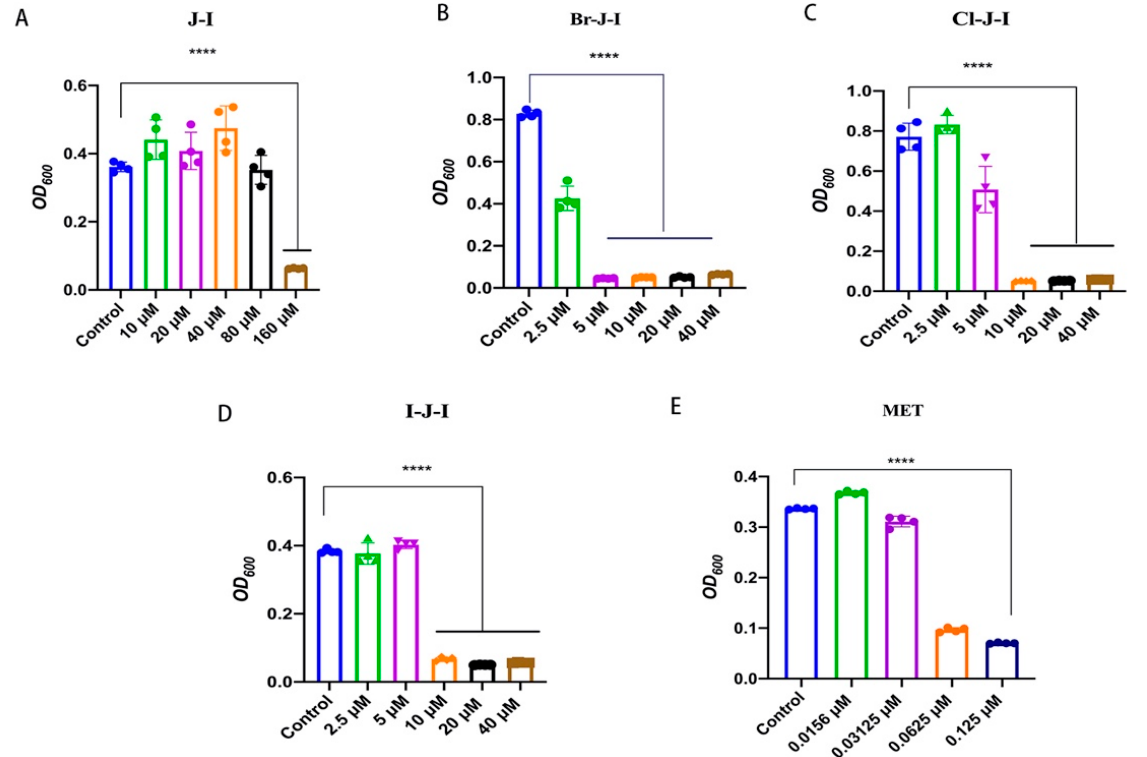
Figure 1. Antimicrobial activities of AMP Jelleine-I (J-I) and its derivatives against Fusobacterium nucleatum ( Fn ). Effects of Br-J-I ( A ), Cl-J-I ( B ), I-J-I ( C ), J-I ( D ), and Metronidazole (MET) ( E ) on the growth of Fn after 24 h treatment of different concentrations of AMPs or positive control MET . Each experiment was repeated at least three times independently. All values are represented as mean ± SEM. **** p < 0.0001, vs. Control.